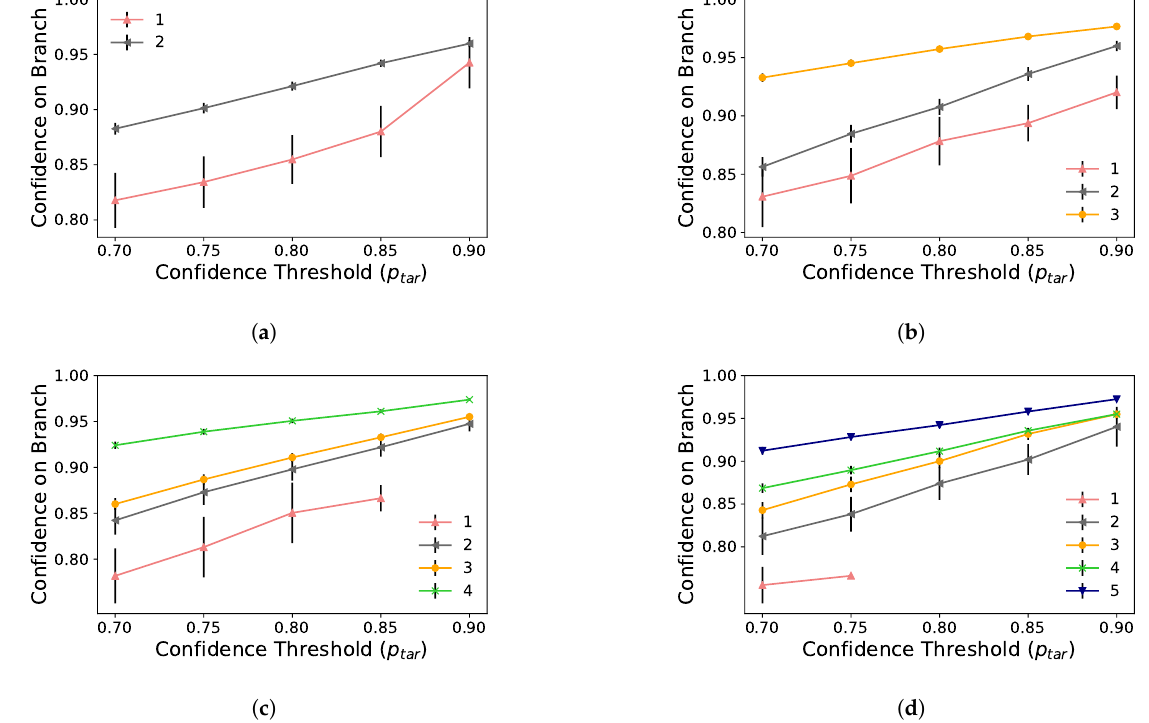
Figure 5. Mean inference confidence for each side branch across different early-exit configurations. Missing data points indicate that no samples were classified at that particular side branch. ( a ) MobileNetV2 trained with 2 side branches. ( b ) MobileNetV2 trained with 3 side branches. ( c ) MobileNetV2 trained with 4 side branches. ( d ) MobileNetV2 trained with 5 side